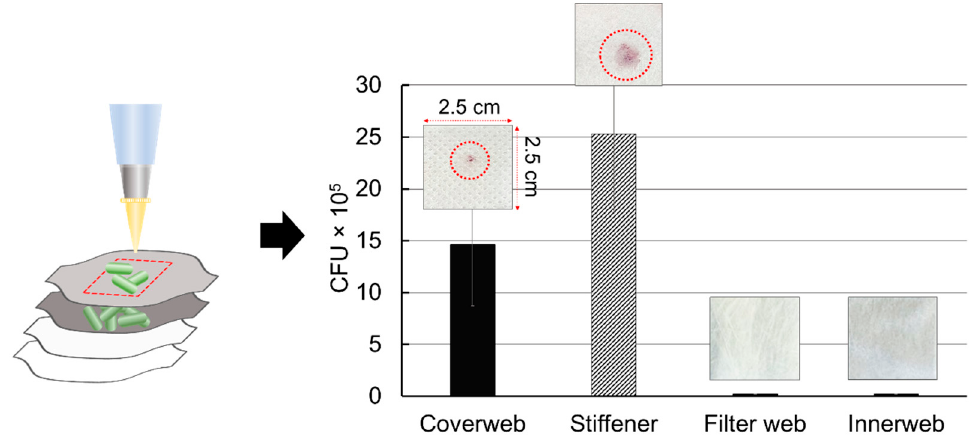
Figure 5. The CFU of loaded E. coli on each layer of untreated respirator A (Resp. A).